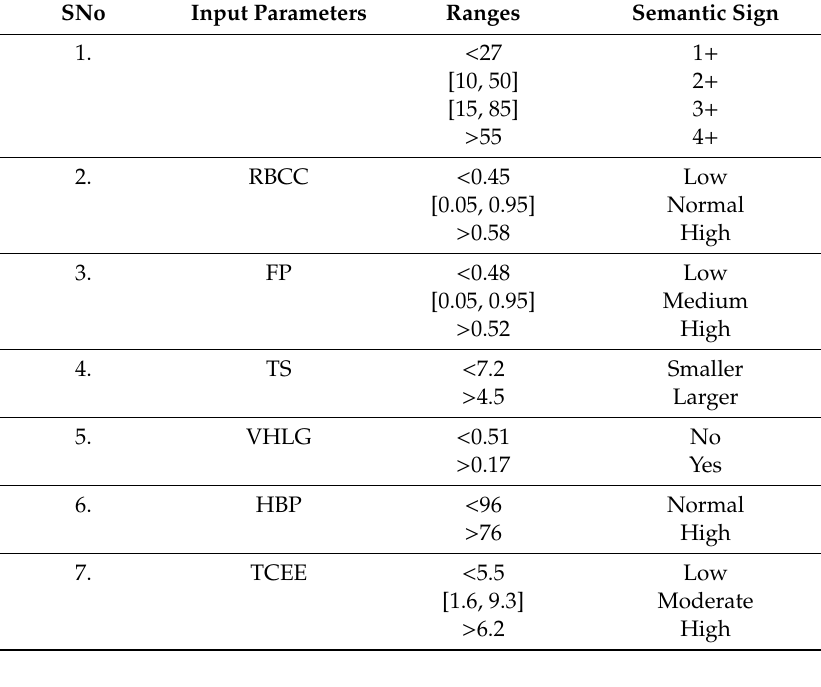
Table 2. Input variables used in layer 2 of the proposed system.